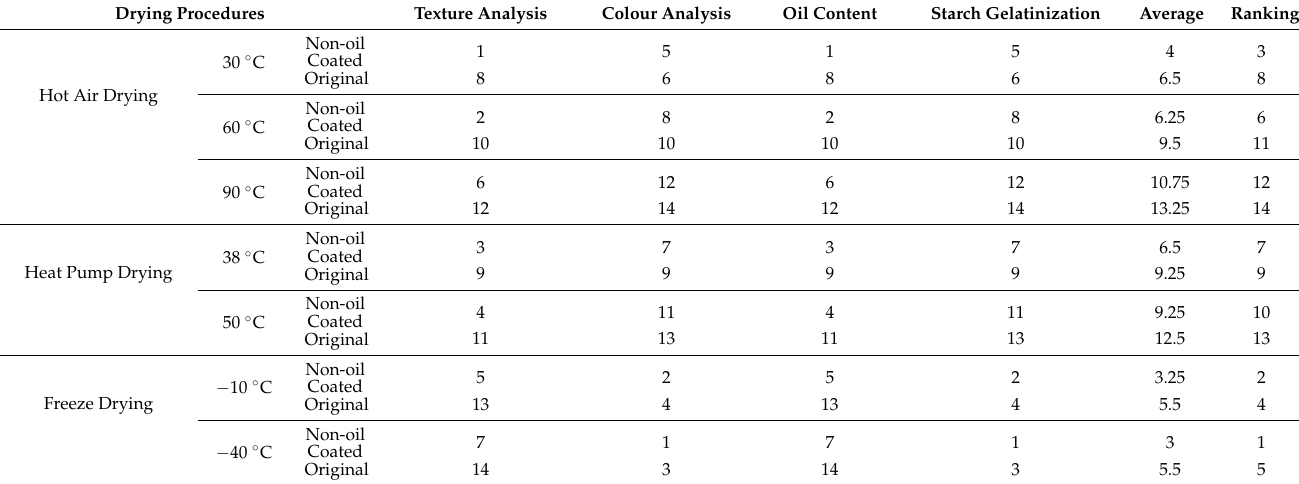
Table 3. The ranking scores for rice noodle quality at different drying